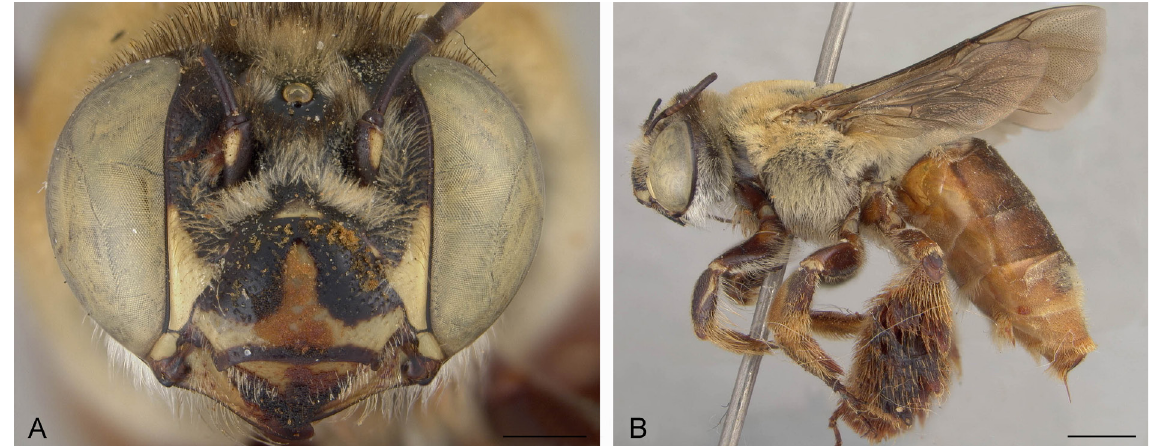
Fig. 5. Centris inermis gualanensis Cockerell, 1912, holotype, ♀ (NMNH; USNM ENT 00534199). A . Frontal view. B . Habitus, lateral view. Scale bars: A = 1 mm; B = 2